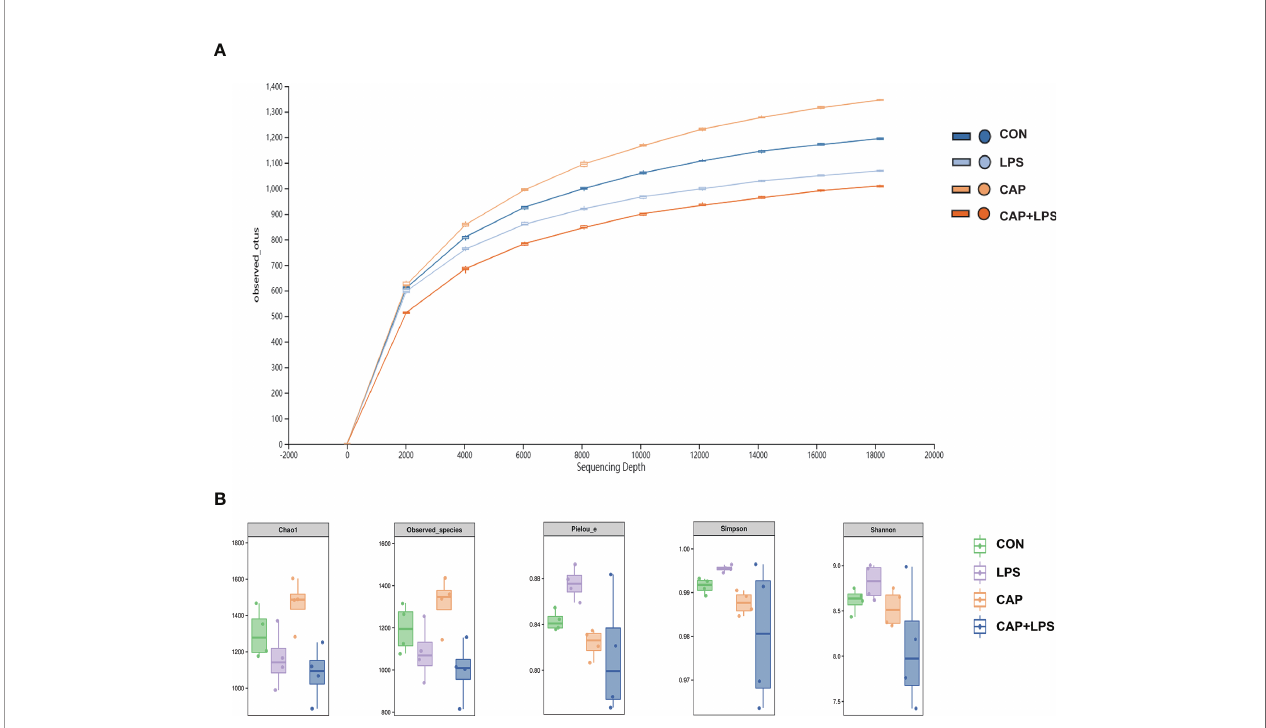
FIGURE 4 | (A) The rarefaction curve to assess the sequencing depth in every group (n = 4); (B) Chao1 estimator, Observed species, Pielou ’ s index, Simpson index, Shannon index (n = 4). Data are presented as box and whisker plots. The box denotes the interquartile range (IQR, 75th to 25th percentiles of the data), and the mean value is represented by a straight line within the box; whiskers extend to 1.5 × IQR, or the most extreme value. The Kruskal-Wallis test was used to conduct one-way ANOVA on the results. And there were no signi fi cant differences among CON, LPS and CAP+LPS groups.